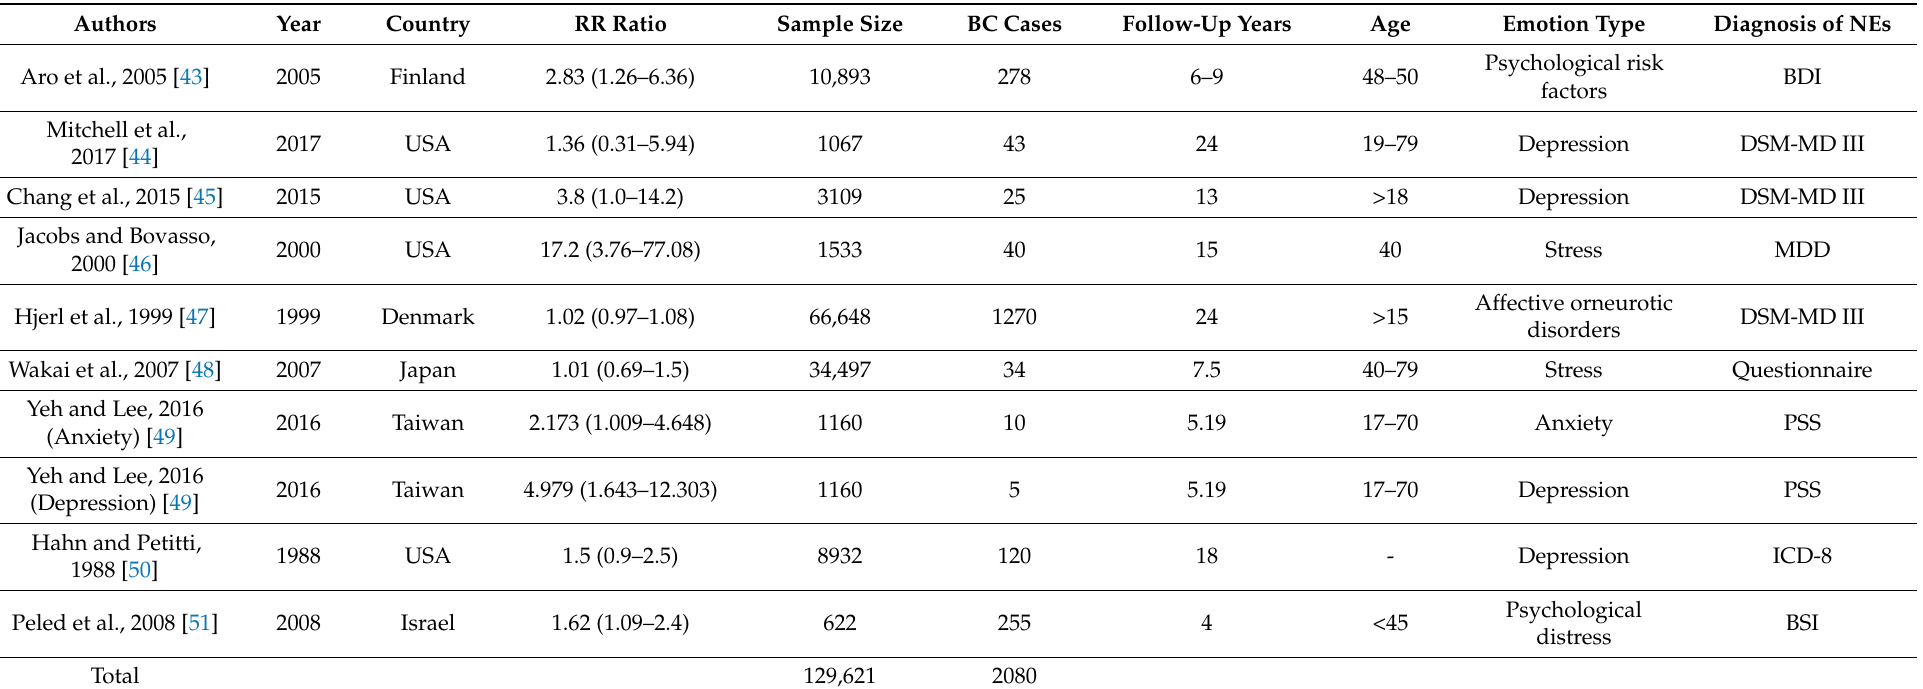
Table 2. Information of included